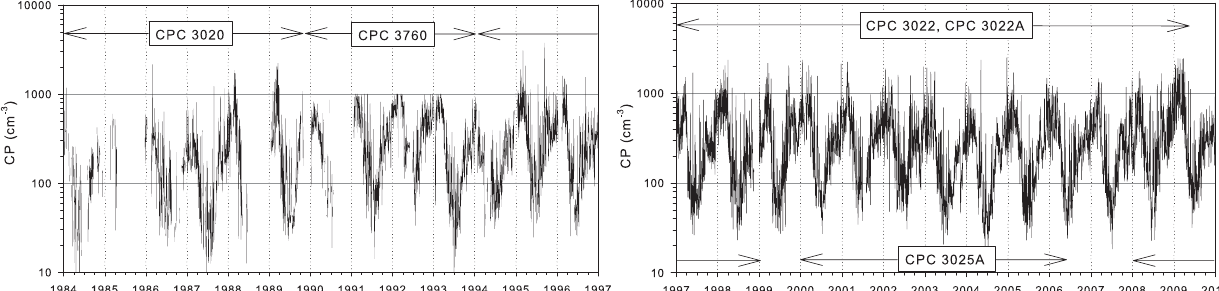
Fig. 1. Time series of the measured CP concentrations (daily means). Also indicated are the operation periods of the different particle counters types. Results from the CPC 3022/3022A are plotted throughout in the lower graph, except from April 2009 ongoing, when only a CPC 3025A was in operation. Note the different 50% cut-off diameters listed in Table